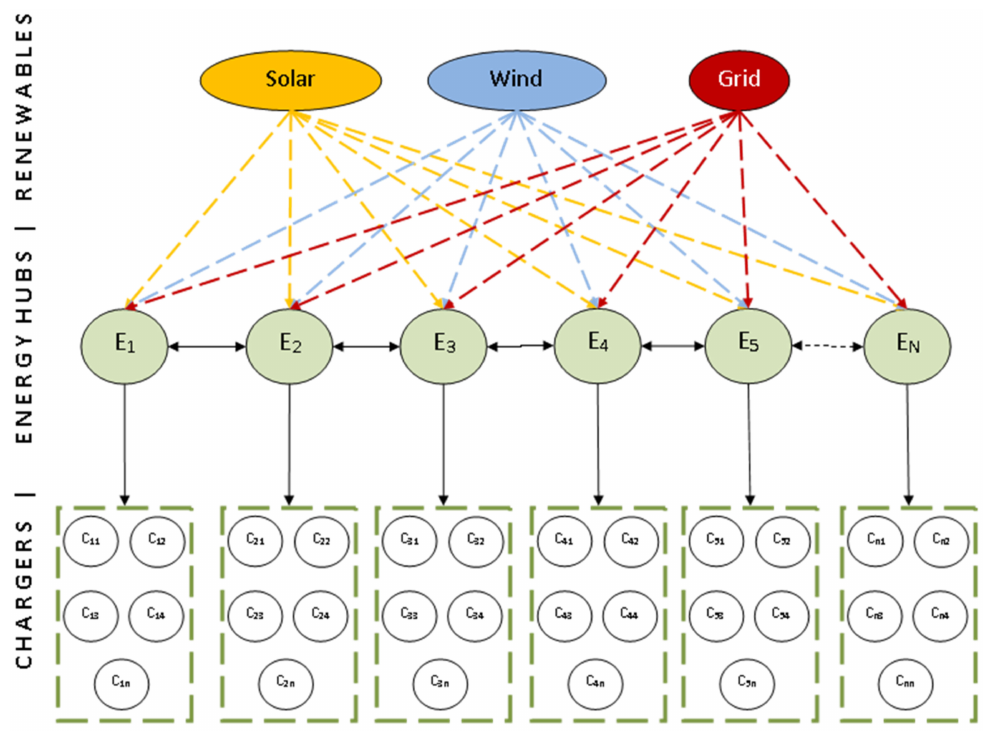
Figure 1. Superstructure of electric vehicle (EV) charging and energy